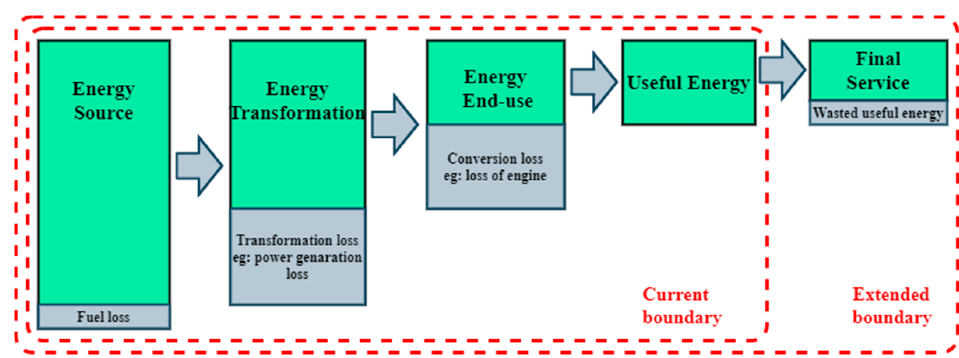
Figure 1. The energy flow of a societal energy system in the Societal Exergy